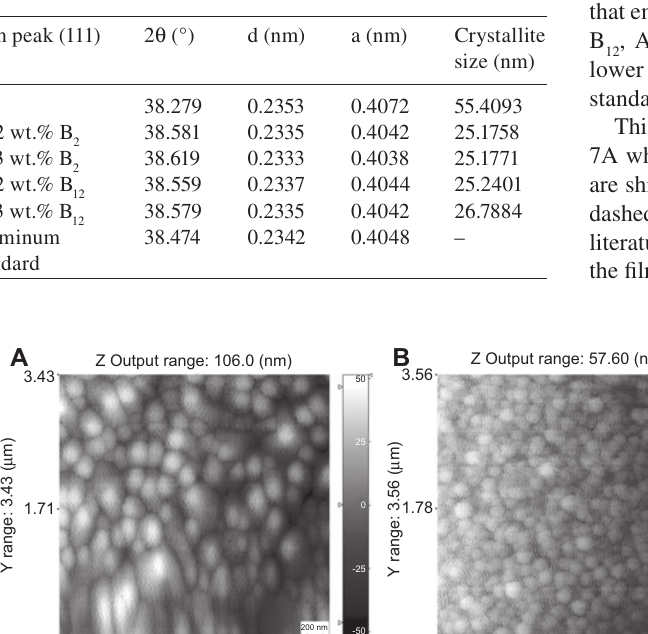
Table 1 Computed Al lattice parameters of the sputtered fi